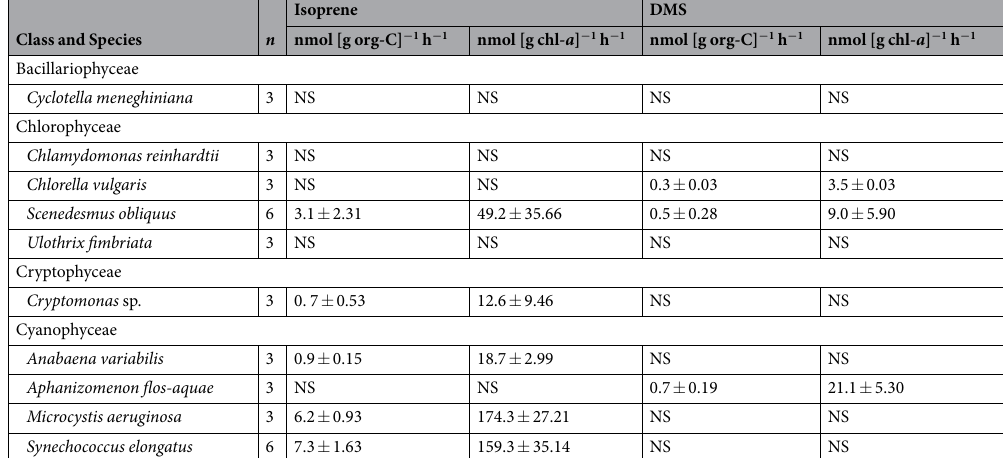
Table 2. Isoprene and DMS production in four classes of freshwater phytoplankton from 10 species after normalization to particulate organic carbon (POC) or chlorophyll- a (chl- a ). ‘NS’ indicates that incubations with algae were not significantly different from controls with alga medium (two-tailed t-test, P >